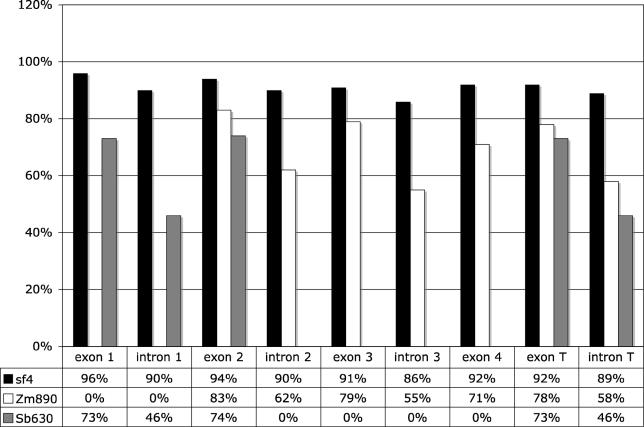
Bar Graph Displaying Percent Similarity of the Setaria (Sf4), Maize (Zm890), and Sorghum (Sb662) Elements with the Rice Element (Os493)
The region analyzed includes the last portion of exon 1, intron 1, portions of exon 2, intron 2, exon 3, intron 3, and the first portion of exon 4. Although percent similarity for exon 1 and intron 1 between Sf4 and Os493 is shown, the corresponding region in Zm890 is not available, nor are sequences for the last two introns of Sb662. The percent figure is the percent identity of each element in the specified region to Os493 in that region. Portions in which no sequence was available are given a 0% value. T Exon and T Intron refer to the sum of exons and introns, respectively, that were compared.